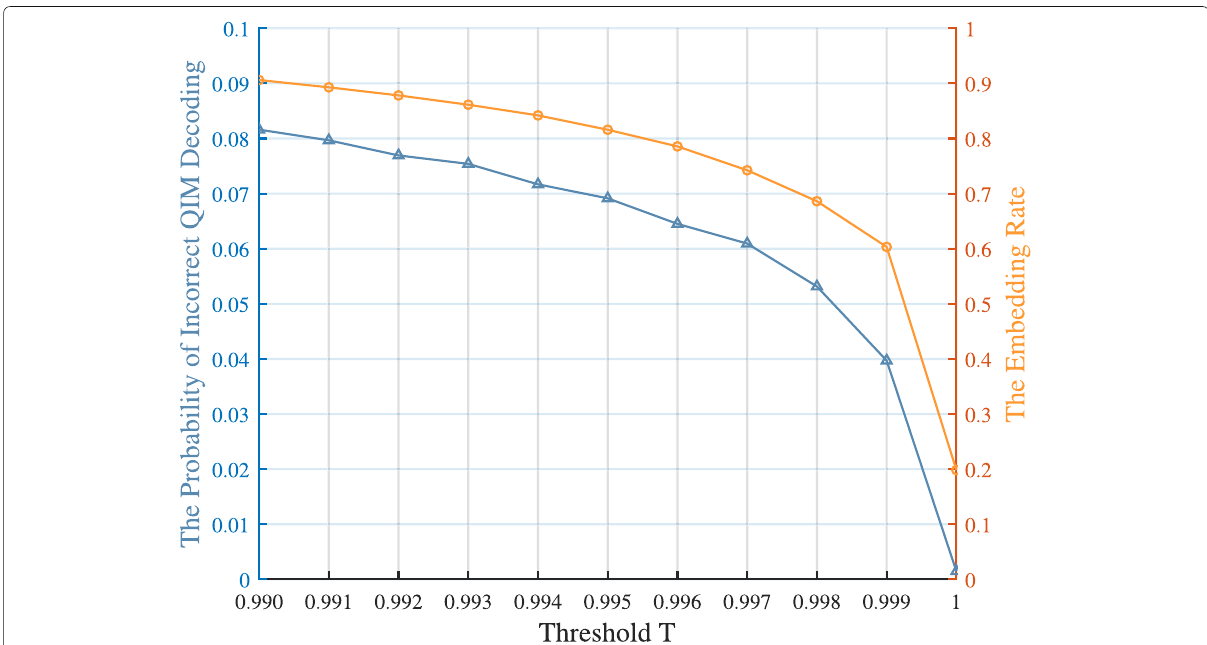
Fig.12 The probability of incorrect QIM decoding and maximum embedding rate under the block size of 16 × 16 and the quantizationstep size of 40